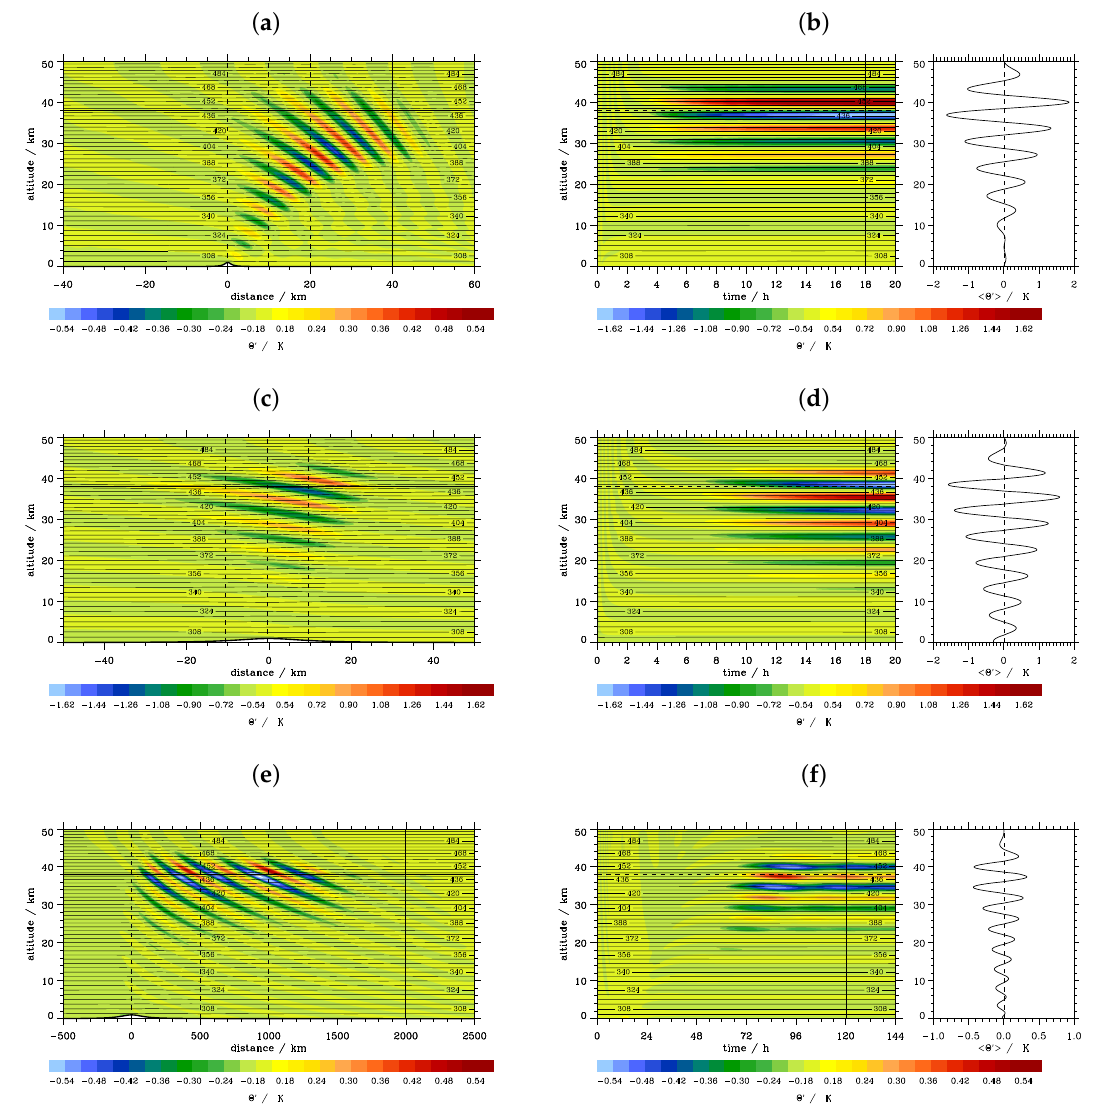
Figure 10. Spatial snapshots left ( a , c , e ) and vertical times series right ( b , d , f ) of the potential temperature perturbations Θ (cid:48) for the three different wave regimes. (a,b) non-hydrostatic wave regime; (c,d) hydrostatic nonrotating wave regime; (e,f) hydrostatic rotating wave regime. The right panels in (b,d,f) depict time-averaged Θ (cid:48) -profiles computed over the period from the time indicated by the vertical line until the end time of the respective panels. The spatial snapshots are taken at t = 125min (a), t = 10h (c) and t = 5d (e). The vertical time series are recorded at x = 10km (b), x = 0 (d) and x = 500km (f), as indicated by the vertical dashed lines in (a,c,e). The amplitude of the surface topography is exaggerated by a factor of 10 in